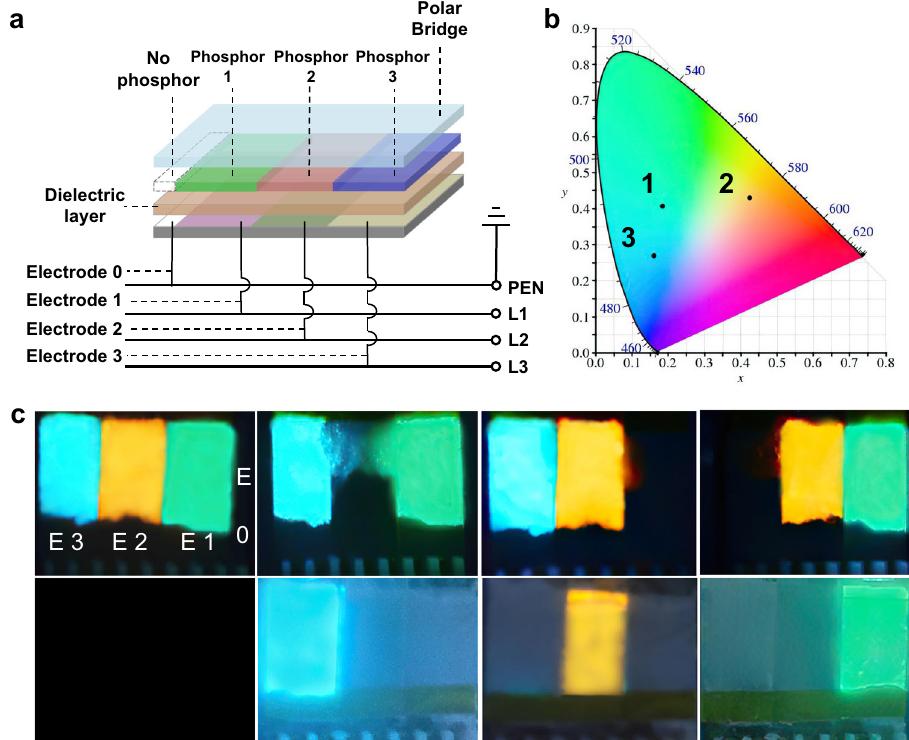
Fig. 3 Schematic illustration of the structure and the control method of the pixel form TPEL devices. a Schematic diagram and connection method using a three-phase four-wire system for a pixel-formed TPEL device (3.5 × 2 cm), in which we used three different phosphor powders to fabricate three separated phosphor layers (Phosphors 1 – 3) aligned to the three different electrodes (Electrodes 1 – 3). Besides that, we also introduced a small extra Electrode 0 (0.5 × 2 cm, next to Electrode 1) connected to a protective neutral wire (PEN) line without any phosphor bladed but with polar bridge covering above it for independent control of each electrode. b CIE diagram of EL emissions corresponding to the three phosphor layers, with their ( x , y ) coordinates (0.188, 0.400); (0.464, 0.433) and (0.165, 0.266) for phosphors 1, 2, and 3, respectively. c Independent control of each electrode and the phosphor emission, simulating all eight different working states for the pixels. E0 – E3 stand Electrodes 0 – 3. The used phosphors: GG45 (phosphor 1, green), GG14 (phosphor 2, orange), and GG65 (phosphor 3, blue). Commercial hydrogel was used as a polar bridge and PET-ITO was used as a